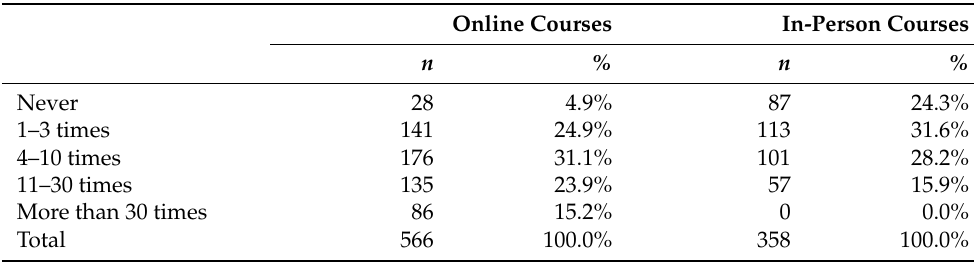
Table 2. In a typical school day, how often do you use your digital devices during your classes